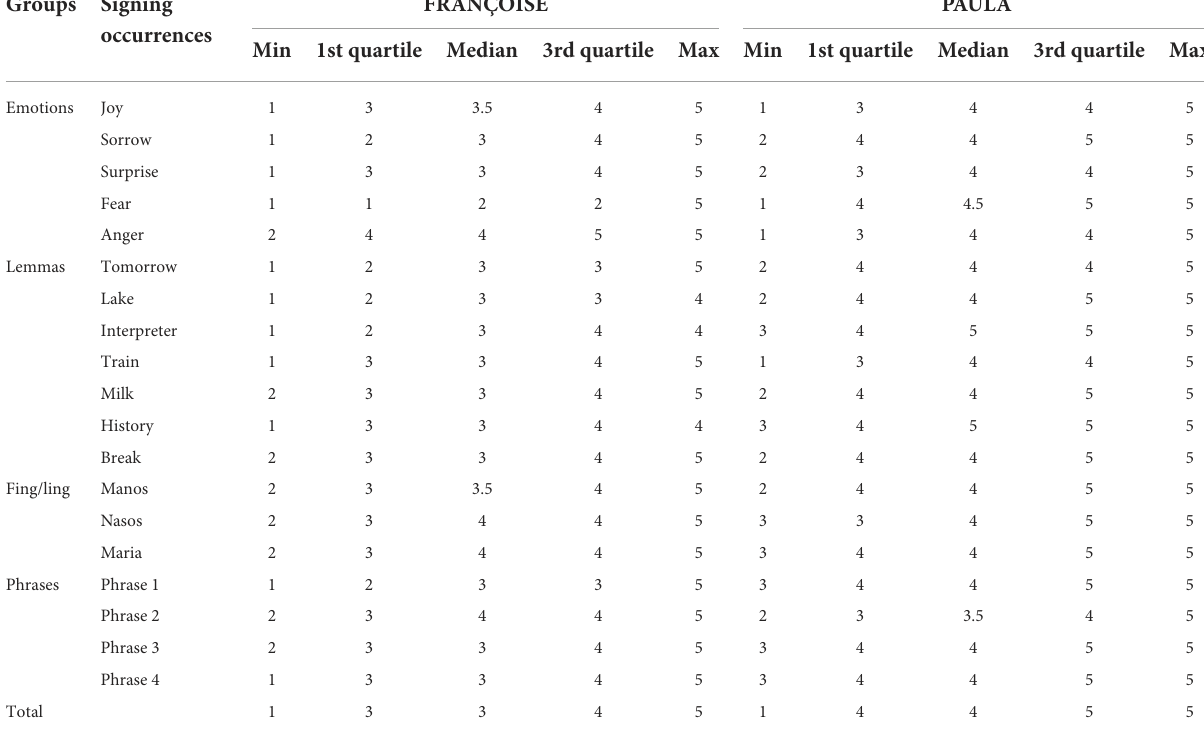
TABLE 1 Analytic overview of median, minimum, maximum, and quartile values for all signing occurrences presented to the participants for both avatars in Part A. Groups Signing